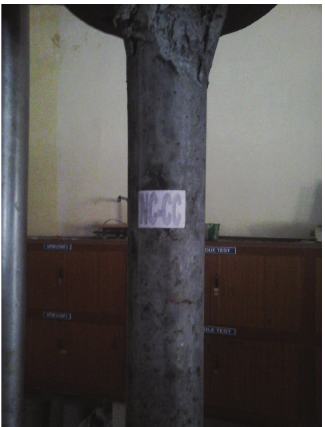
Figure 3: Failure pattern of reference column.